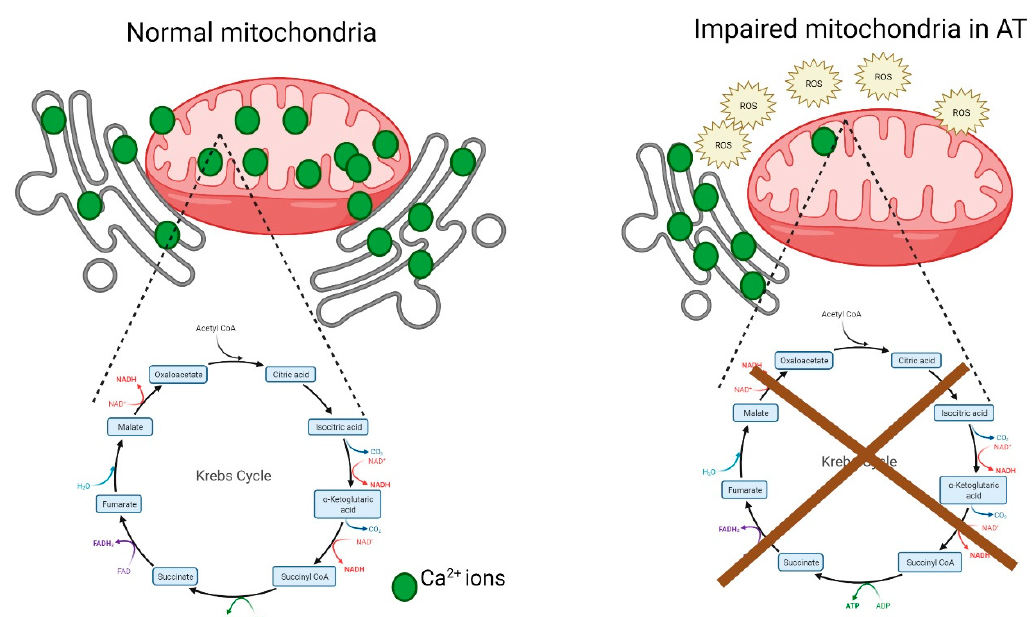
Figure 5. The endoplasmic reticulum (ER) mitochondria form contact sites that control lipid, calcium homeostasis and mitochondrial metabolism. The transfer of Ca 2+ ions from the ER reserves to mitochondria is crucial for the TCA cycle, as Ca 2+ ions act as catalysts for several enzymatic interconversions within the TCA cycle.